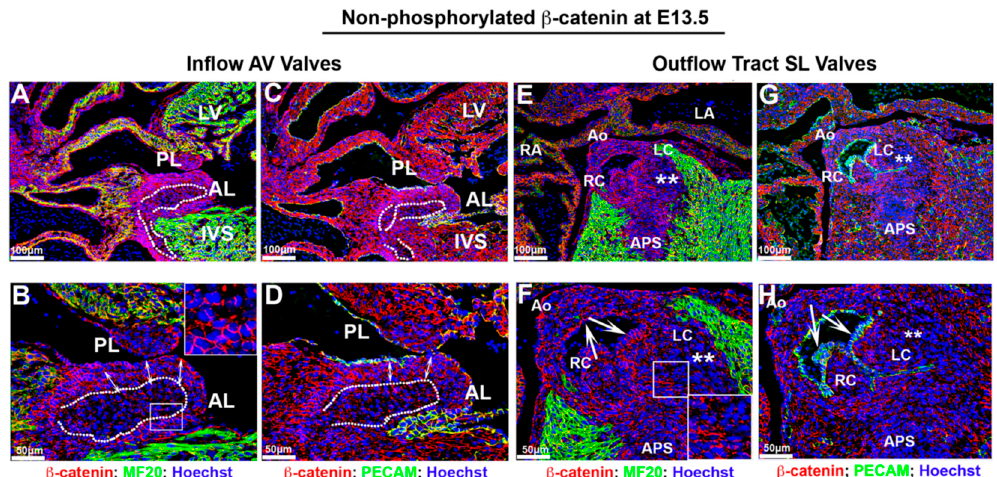
Figure 5. Membrane non-phosphorylated β -catenin at E13.5. ( A – D ) Membrane β -catenin expression was prominent in atrioventricular valves. However, within the central mass of valve interstitial cells (( B , D )—dotted line), the staining pattern was punctate and not continuous on the cell membrane as compared to cells in subendocardial region (( B , D )—arrows). ( E – H ) Membrane β -catenin displayed a similar spatial pattern as AV valves within the outflow tract mesenchyme of the semilunar valves. However, the majority of the interstitial mesenchyme in these valves presented a punctate pattern rather than circumferential β -catenin expression (( F )—boxed region). The outflow tract valve endocardium showed membrane expression of β -catenin along the basal aspect of these cells, which co-localized with the adherens junctions marker Pecam (( F , H )—arrows; Green: PECAM). Majority of interstitial cells within the left coronary cusp revealed very low to undetectable expression of β -catenin (( E – H )—asterisks). Outside of the valves, membrane expression of β -catenin was robust in all areas (cardiomyocytes, the epicardium, aortic wall and ventricular endocardium). AL = anterior leaflet, PL = posterior leaflet, IVS = interventricular septum, LV = left ventricle, RA = right atrium, Ao = aorta, APS = aorticopulmonary septum, RC = right coronary cusp, LC = left coronary cusp.